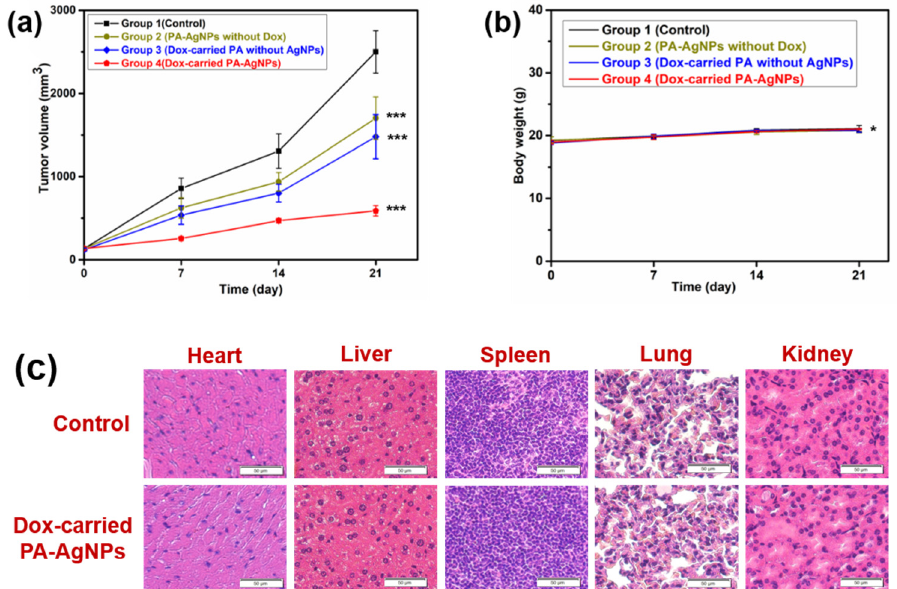
Figure 8. ( a ) In vivo antitumor efficacy of PA-AgNPs; ( b ) body weight change of groups as a function of time (Data characterize the mean ± SD, n = 3, * p < 0.05 and *** p < 0.01 compared with the control group, Student’s t -test.); and ( c ) H&E staining of major organs.